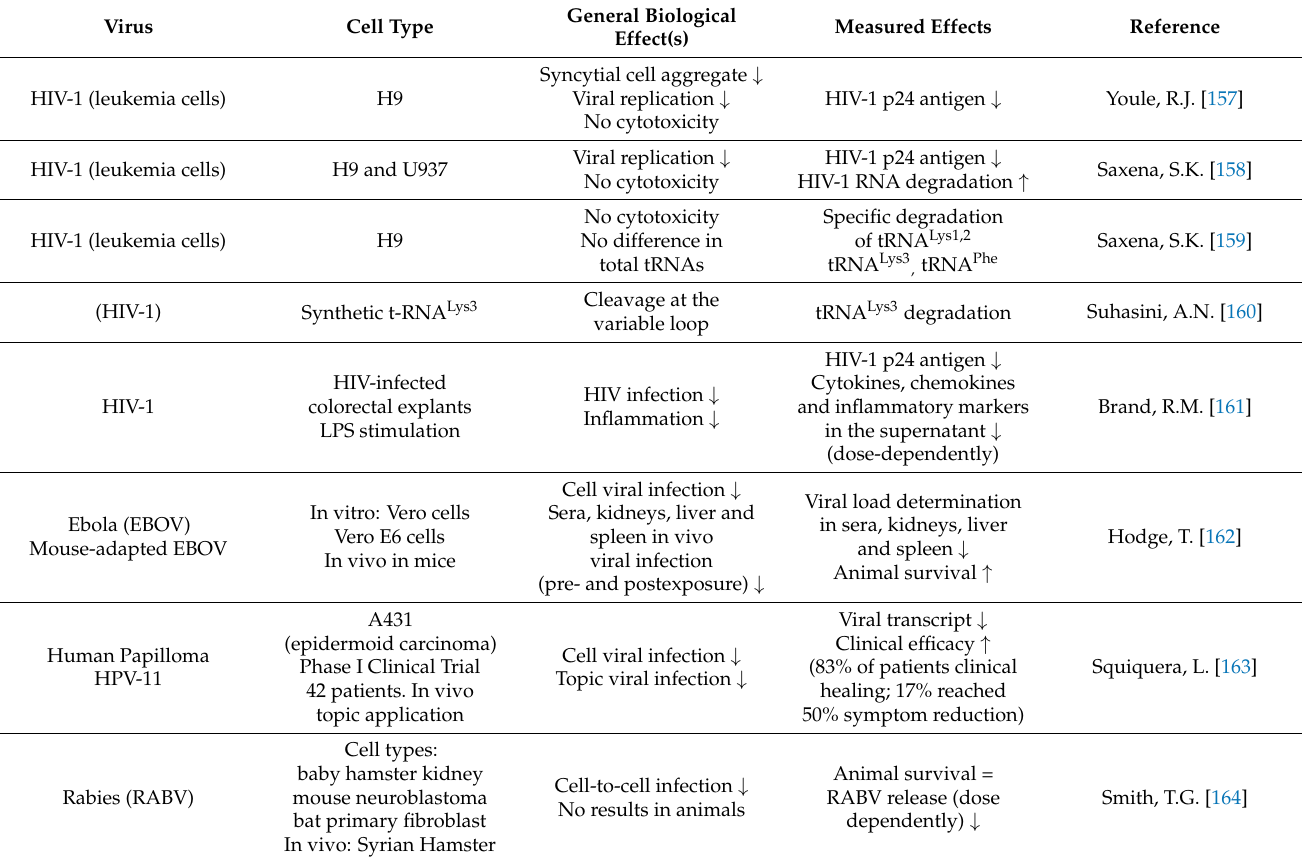
Table 2. Effects of ONC on